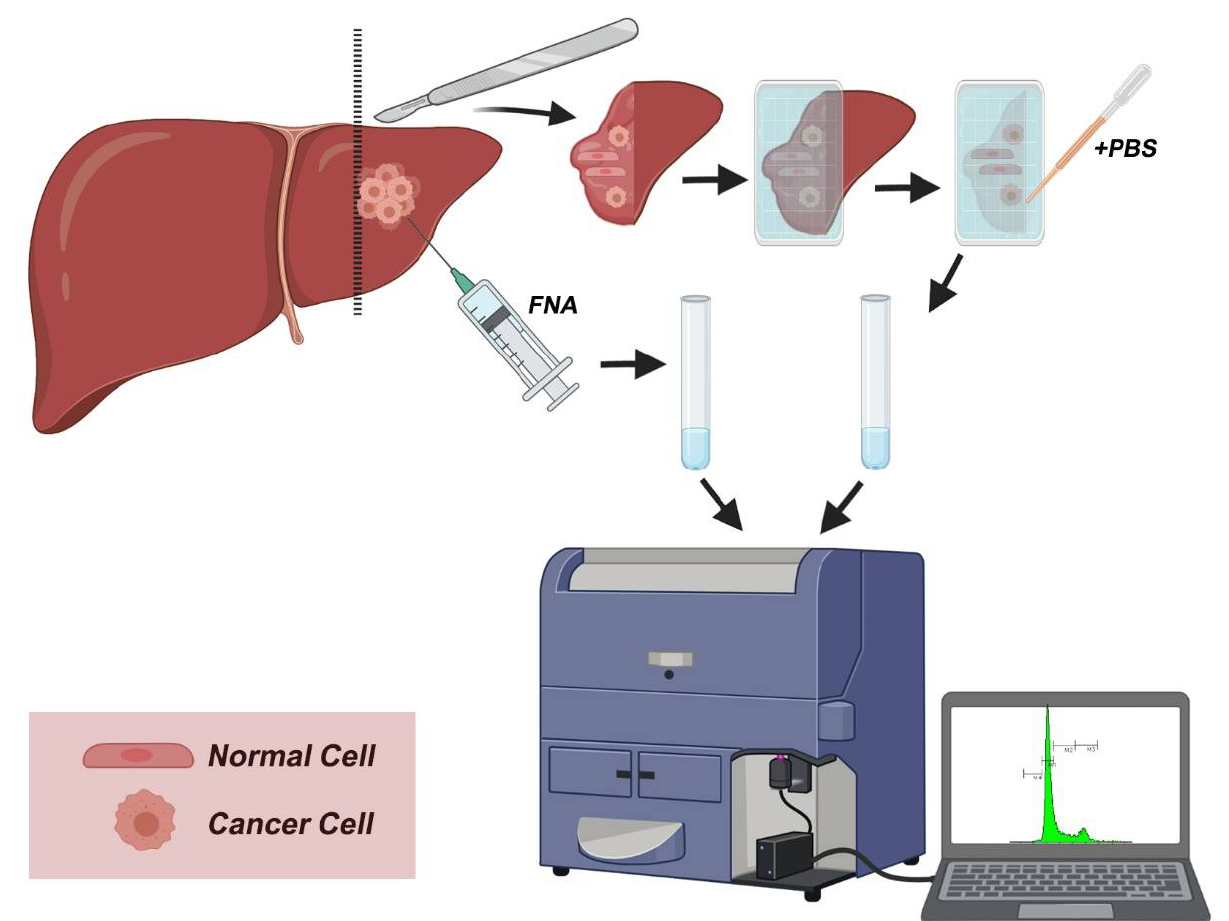
Figure 2. Workflow overview. During surgery, the excised surface is imprinted into a nylon membrane and cells are transferred into the imprint. Following PBS wash and filtration, the sample is stained with propidium iodide and analyzed with flow cytometry to quantify DNA content. A positive control sample is prepared from fine-needle aspirate (FNA) and analyzed in parallel to imprinted samples.